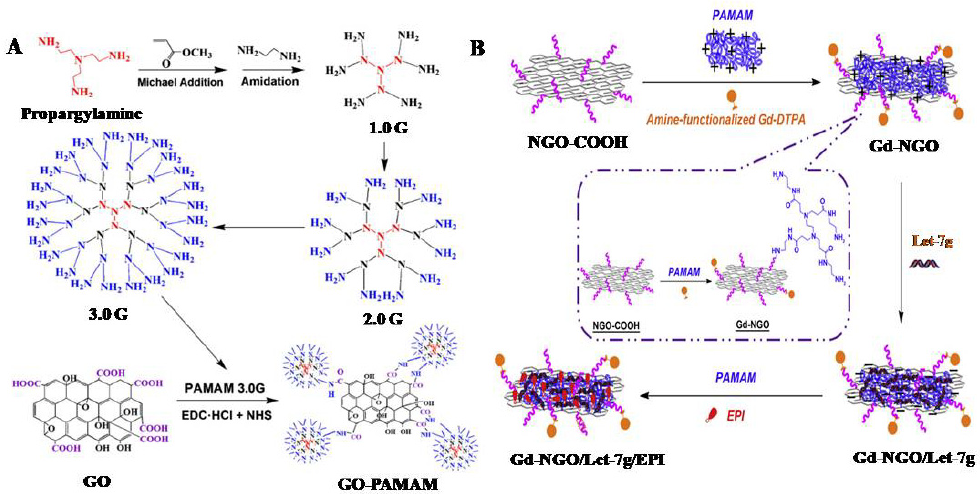
Figure 3. ( A ) Synthetic route of PAMAM 3.0G and GO-PAMAM [72]. ( B ) Schematic of